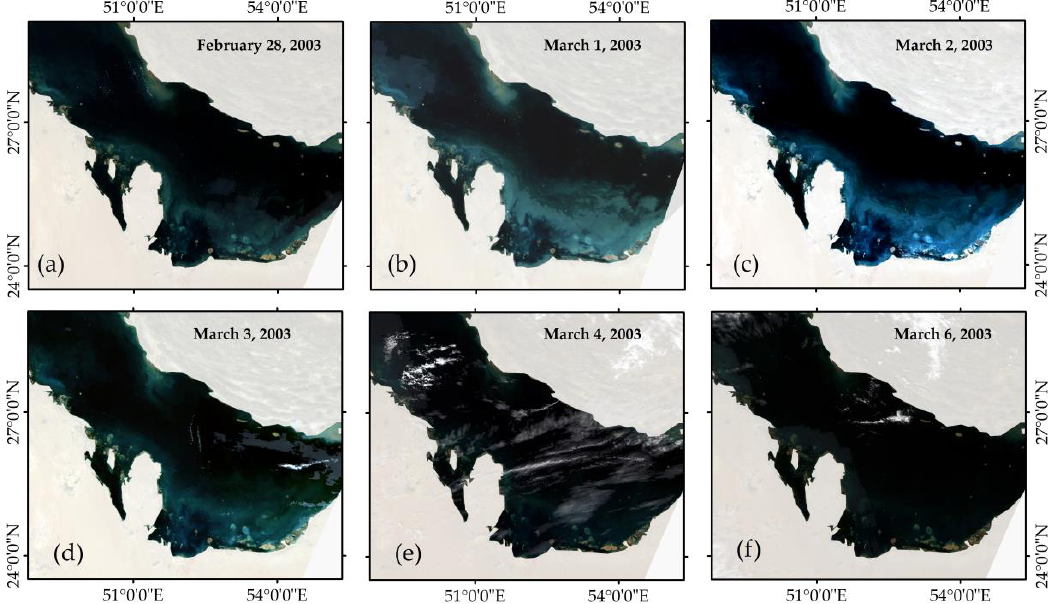
Figure 3. Initiation and disappearance of a whiting event in 2003 based on acquired MODIS images.